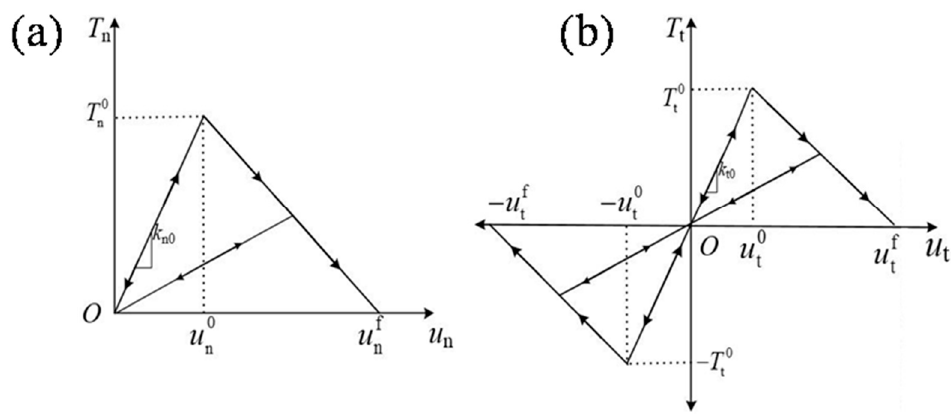
Figure 2. Schematics of the traction–separation relations in the ( a ) normal direction and ( b ) shear direction.